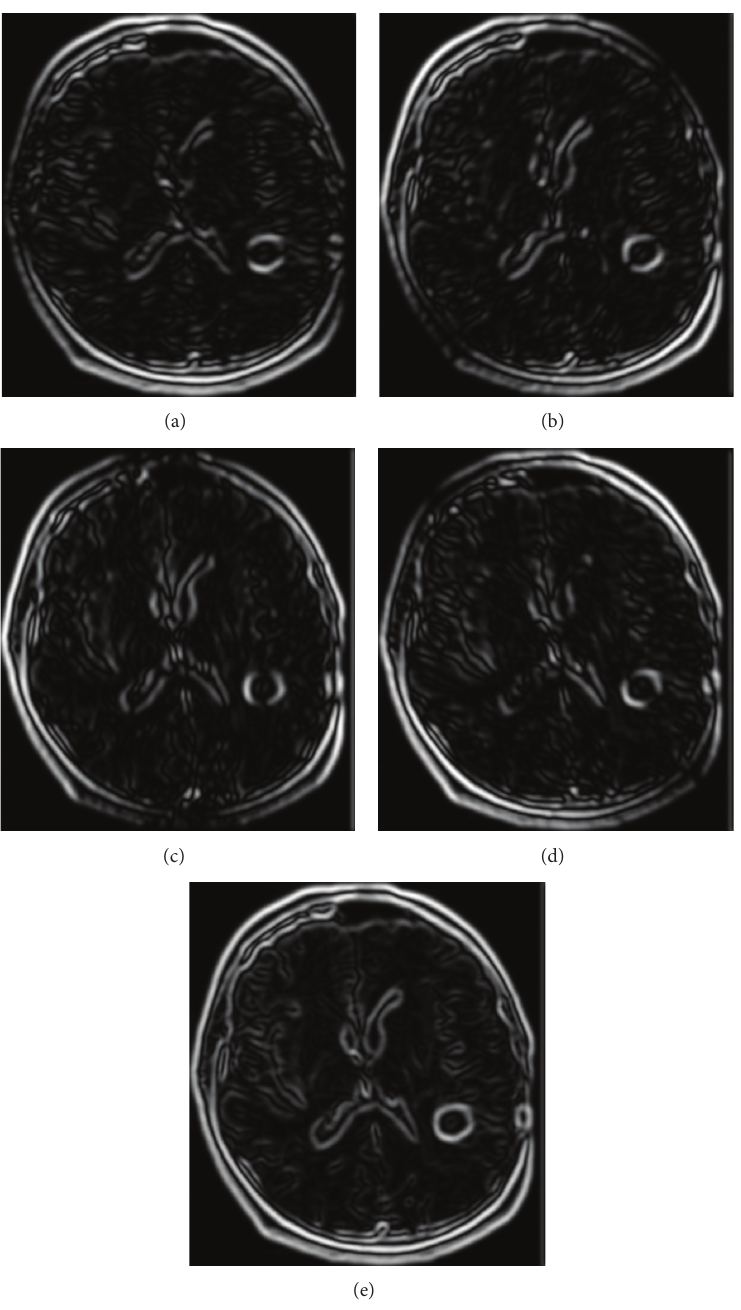
Figure 4: The GWT of a CT scan brain image for different orientation factors (𝜎 = 0.1 and 𝜔 = 0.005) ; (a) 𝜋 /4, (b) 𝜋 /2, (c) 3 𝜋 /4, (d) 𝜋 , and (e) total